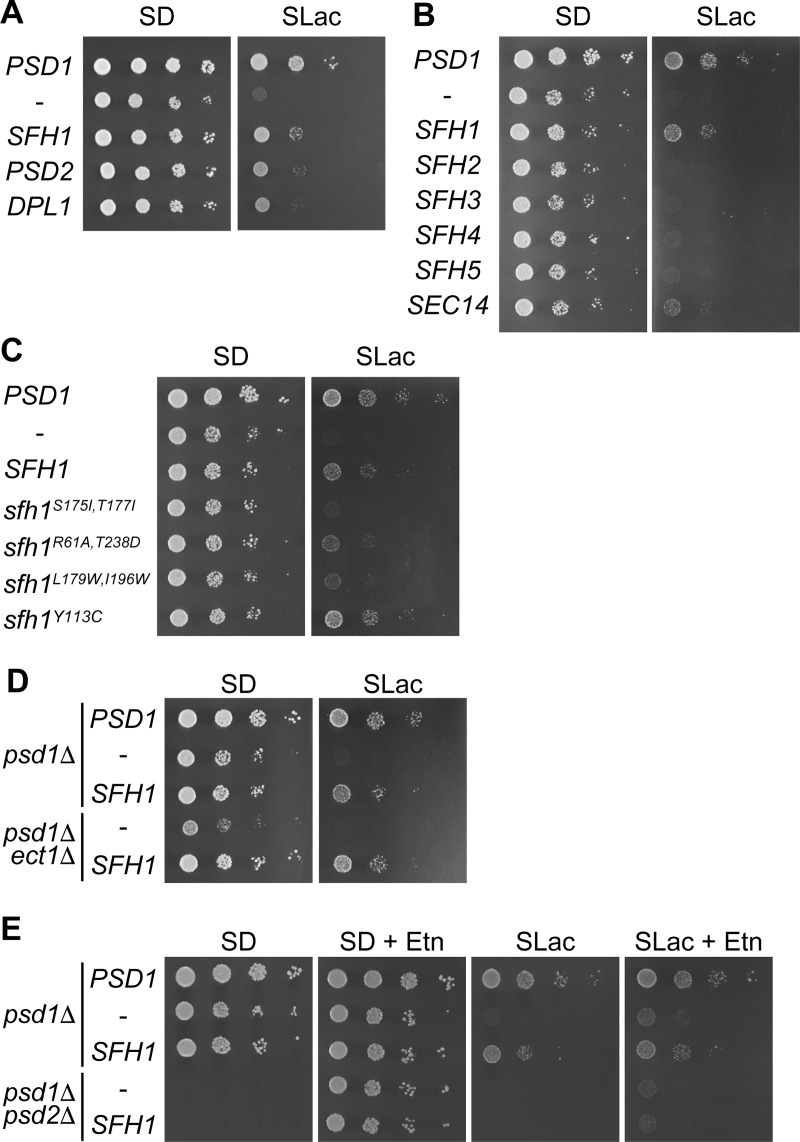
Overexpression of SFH1 restores the growth of the psd1Δ strain on lactate.Cells were cultured in SD medium to logarithmic phase and were spotted on SD or SLac media in ten-fold serial dilutions and were incubated on SD medium for 2 days or on SLac medium for 7 days. (A) Growth of the psd1Δ strains overexpressing genes obtained from the screening. (B) Growth of psd1Δ strains overexpressing genes encoding Sec14 family proteins, Sec14 and Sfh1–Sfh5. (C) Growth of the psd1Δ strains overexpressing SFH1 mutants, sfh1S175I,T177I, sfh1R61A,T238D, sfh1L179W,I196W, and sfh1L179W,I196W. (D) Growth of psd1Δect1Δ overexpressing SFH1. (E) Growth of psd1Δpsd2Δ overexpressing SFH1. Etn was added to final concentration of 1 mM.